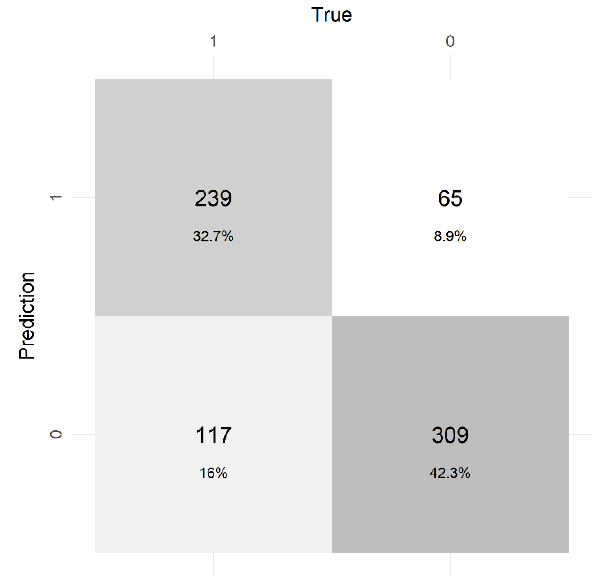
Figure 6. Confusion matrix of final model predictions compared to true values of test data collected off the Eastern Shore of Virginia, USA, 2012–2019. We used an 85% subset of the data to train the model ( n = 4134) and a 15% subset to test the model ( n = 730). Values and percentages are displayed as true positives (top left), false positives (top right), false negatives (bottom right), and true negatives (bottom left). Shading indicates more frequency of any categorization—darker indicating more weight.